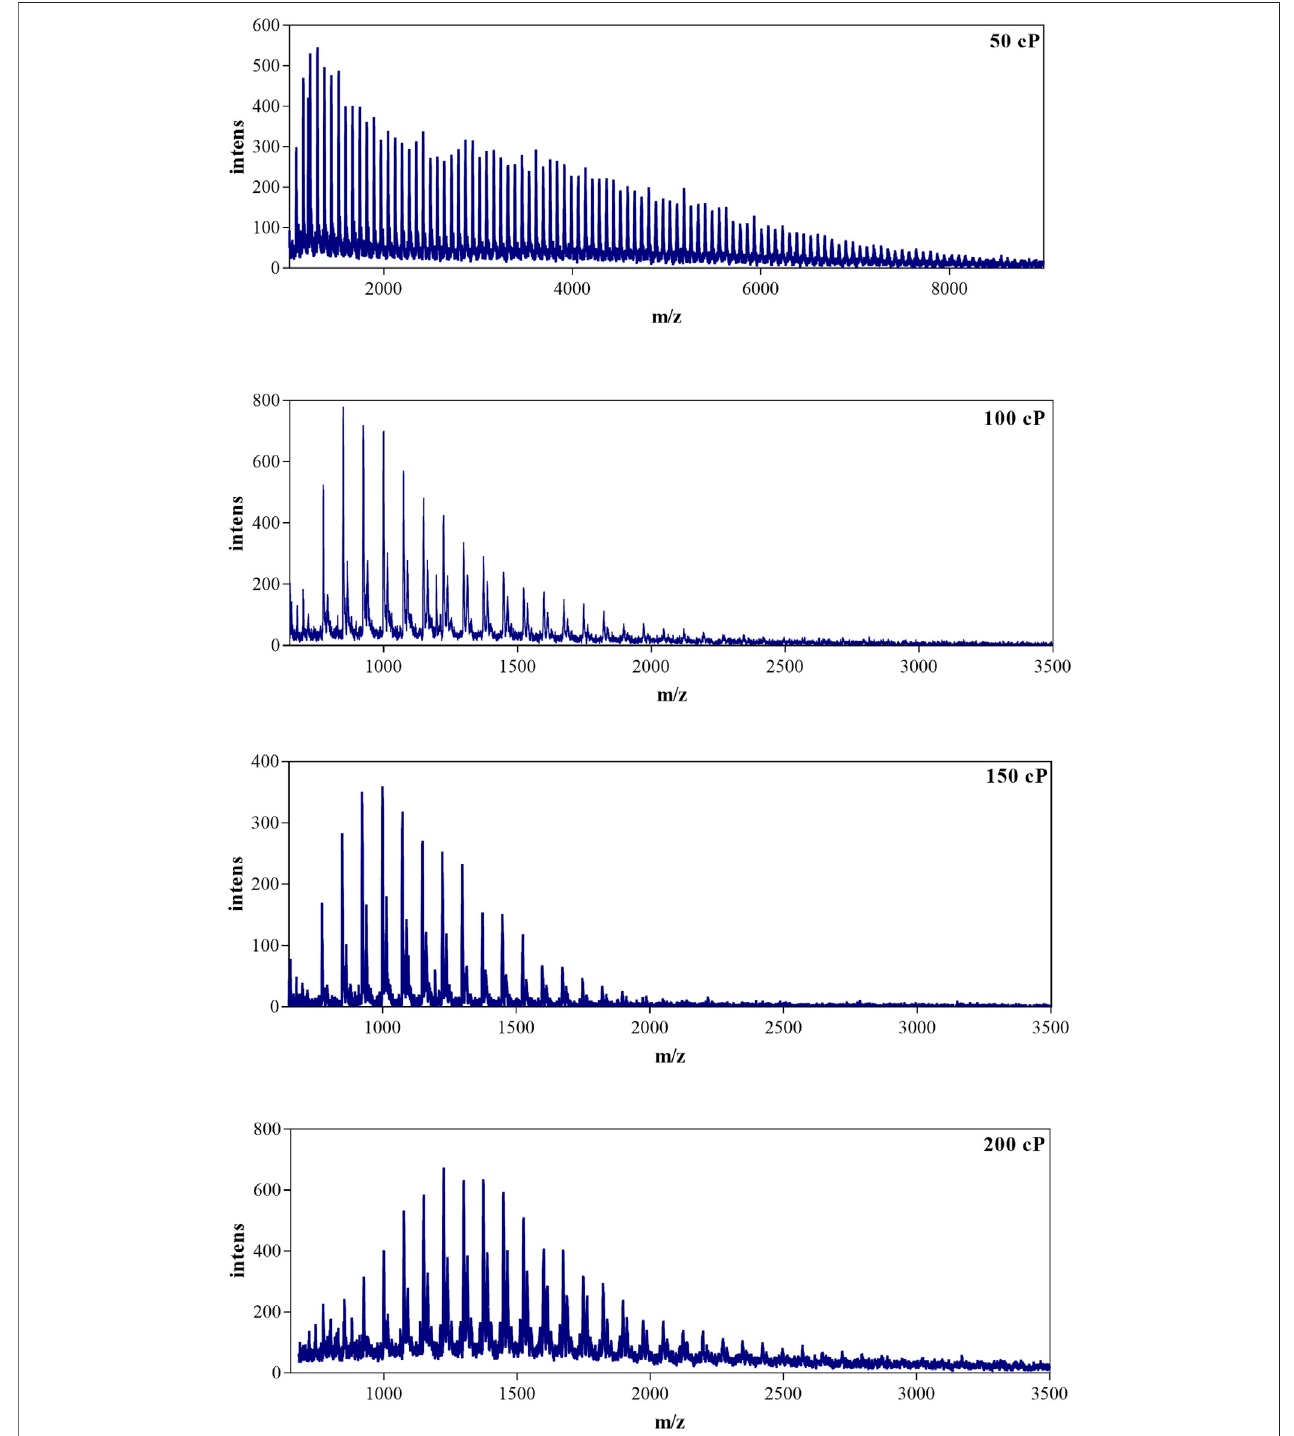
FIGURE 7 | MALDI-TOF MS of hydroxyl silicone oils (50 cP, 100cP, 150cP and 200 cP) with the matrix of DHB modi fi ed by pyridine and NaAc.